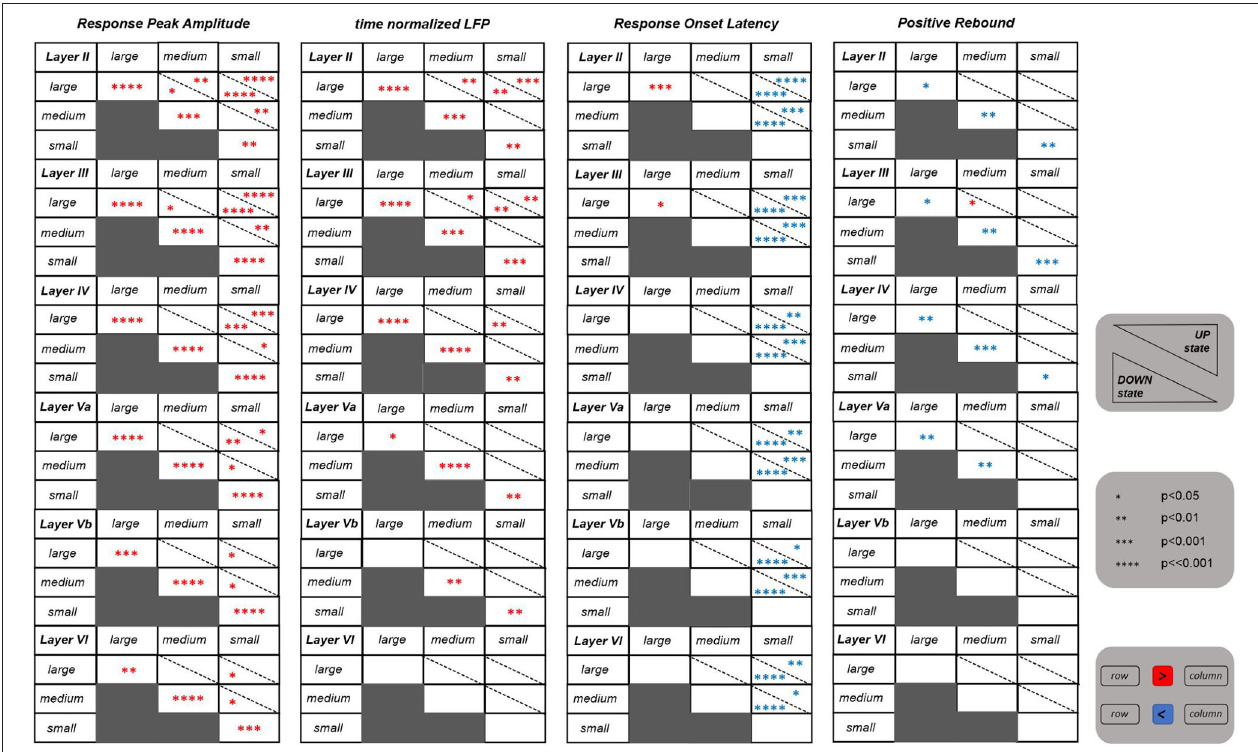
FIGURE 2 | Statistical results for four features extracted from the evoked LFPs. Each table shows the results referring to one specific feature for all the six investigated layers. Each table is consisting of six blocks, each one corresponding to one layer as indicated on the top left of the block. The statistics was performed by comparing between the three different stimulation intensities (i.e., large, medium, and small) as well as between the UP and DOWN state condition. The number of asterisks indicate the strength of statistical significance (i.e., *, **, ***, **** correspond, respectively, to p cells of the main diagonal of each layer block compare the feature values between the UP and DOWN state condition for each stimulation intensity separately. The asterisks outside the main diagonal compare the values of each feature for the UP (upper right triangle) and DOWN state (lower left triangle) conditions separately, comparing between pairs of different stimulation intensities, at each layer. Red and blue asterisks indicate, respectively, a significant increase and decrease of values of a row against the corresponding